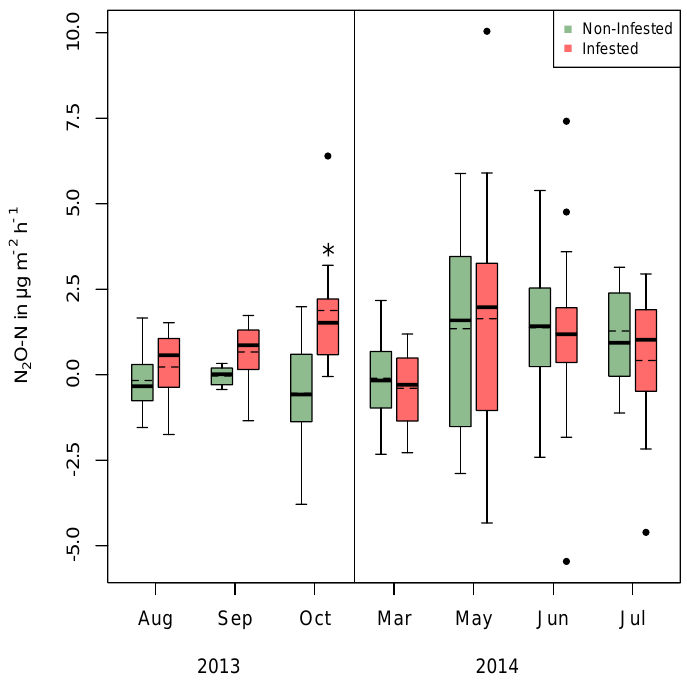
Figure 2. N 2 O-N emissions ( µ g m − 2 h − 1 ) from the mineral soil during an outbreak of the nun moth ( Lymantria monacha L.) in 2013 and 2014 and the adjacent noninfested control of Scots pine ( Pinus sylvestris L.) forest sites. Infested = red, noninfested = green, Aug = August, Sep = September, Oct = October, Mar = March, Jun = June, Jul = July. Box plots show means (dotted lines) and medians (solid lines) ( n = 9 in 2013 and 15 in 2014 for each plot). Whisker extension equals 1.5 times interquartile range distance. Asterisks indicate significant differences between infested and control plots within one sampling time (paired Wilcoxon signed-rank tests, p ≤ 0.050).